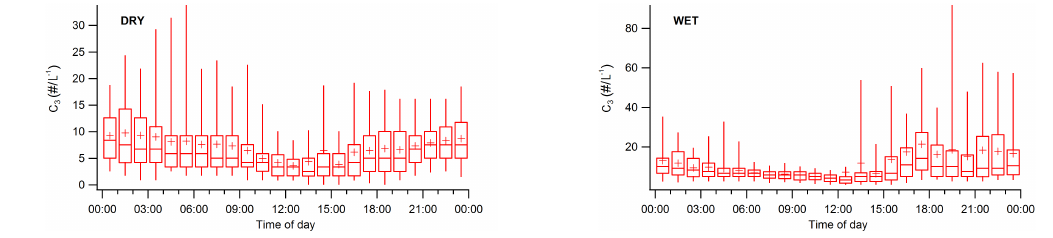
Figure 5. As Fig. 3 but showing cluster C 3 during dry periods (top), and wet periods (bottom).